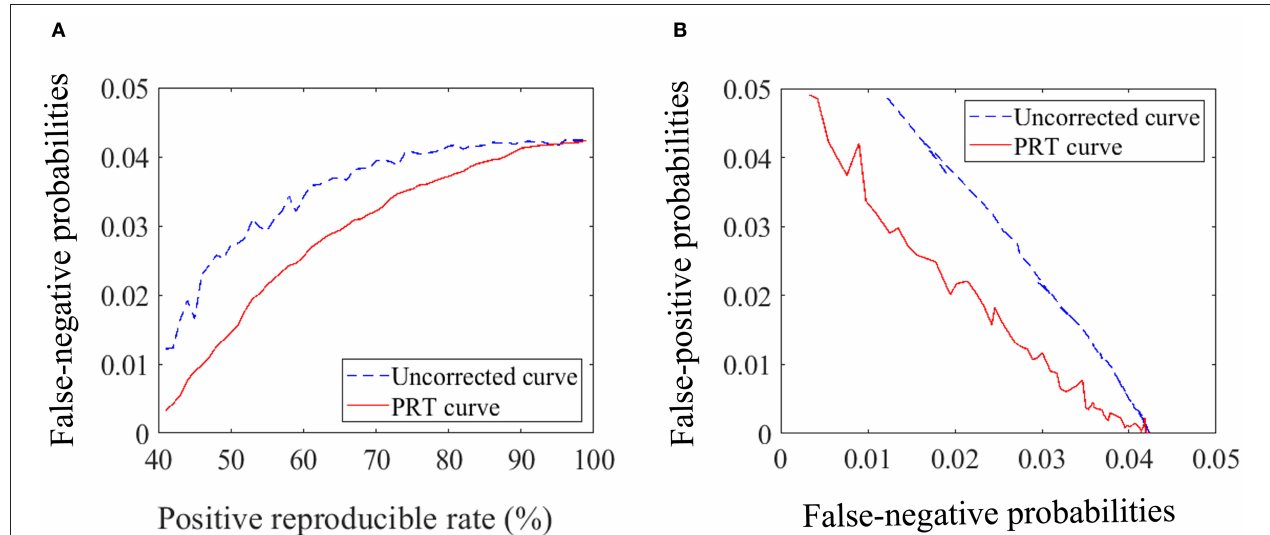
FIGURE 1 | Statistical analysis and comparison. (A) Diagram of the relationship between the probability of false negative and the positive reproducible rate. (B) Diagram of the relationship between the probability of false positive and negative.